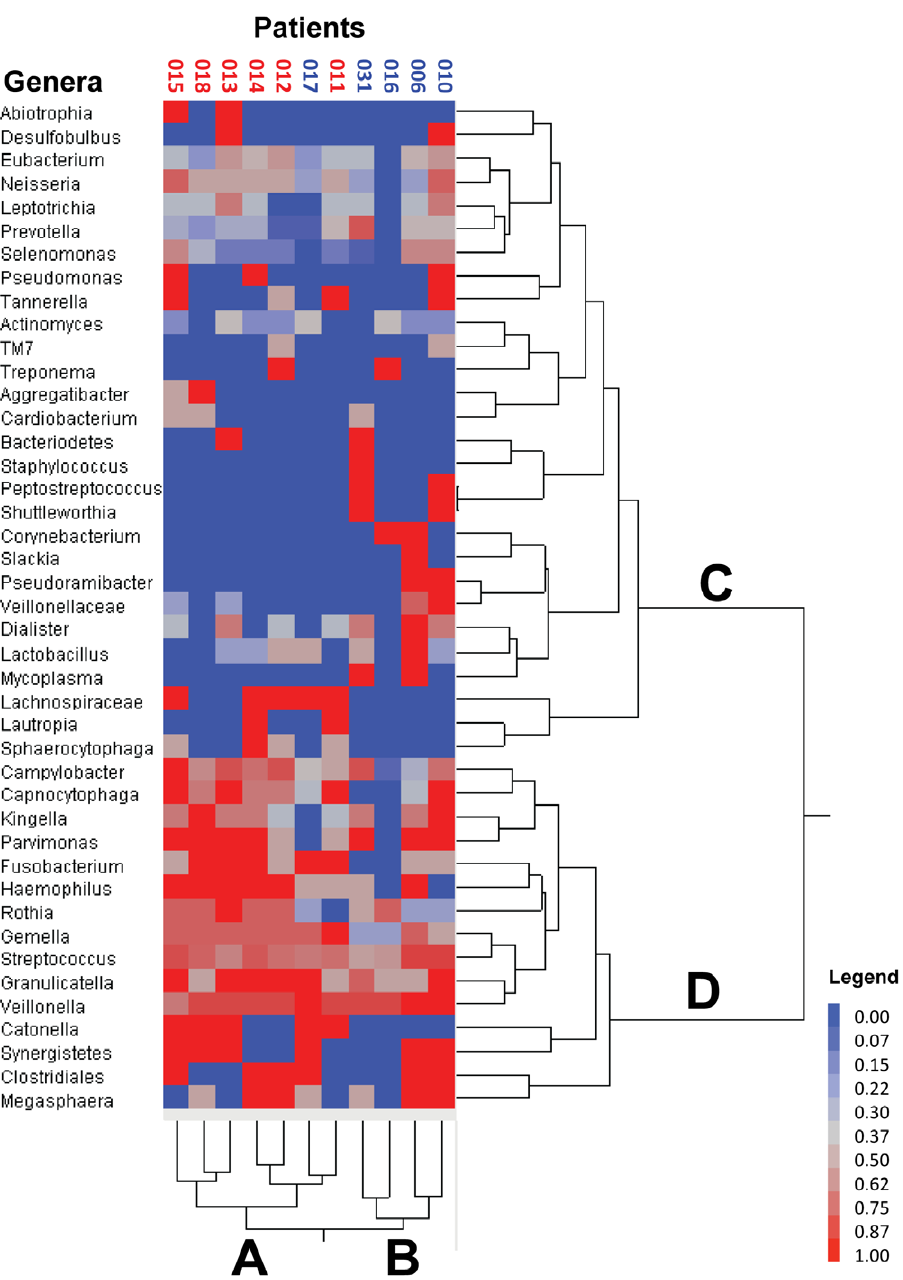
Figure 3. Two Way Cluster of Genera by Patient. Fraction of positive probes all sites and all times by genera and patient. The two way hierarchical cluster analysis using Ward’s distance measure without standardization was calculated. Each probe was converted to a 1 (present) or a 0 (absent) based on the intensity range of the microarray data. The 155 probes were then divided among 43 genera and the proportion of positive probes within each genus was calculated. Cluster A consists of mostly NoRSS and Cluster B consists of RSS patients with one exception (017). Frequently occurring probes are in Cluster D while less frequently occurring probes are Cluster C. Supplementary material (Table S1) lists the probes and the assigned genera for this figure. NoRSS=patients who do not develop respiratory signs and symptoms. RSS=patients who develop respiratory signs and symptoms. [Note: Two probes ( Sphaerocytophaga species strain S3) are listed in Sphaerocytophaga genus but are considered as synonymous with Capnocytophaga genera in the Human Oral Microbiome Database (HOMD) 15]. Selenomonas species Oral Clone CS002 oral taxon 131 remains in Selenomonas genus despite being re-classified into Mitsuokella genera Oral Clone CS002 by HOMD. Eubacterium PUS9170_MCE10174 remains in the Eubacterium genus.] crosses) and after (red circles) specimens are in close proximity to each other in this plot.